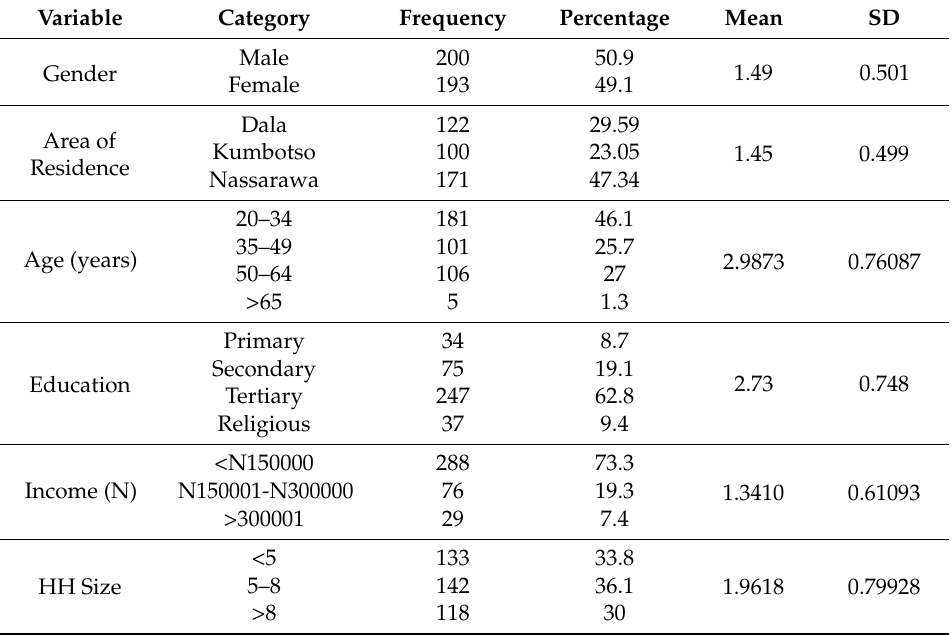
Table 1. Demographic characteristics of the respondents.